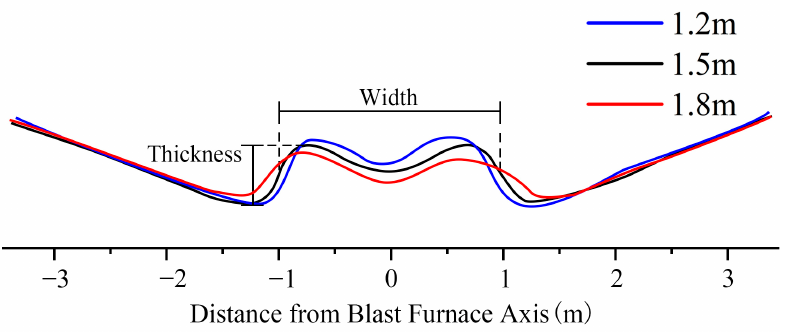
Figure 6. The sampling area diagram of data analysis.